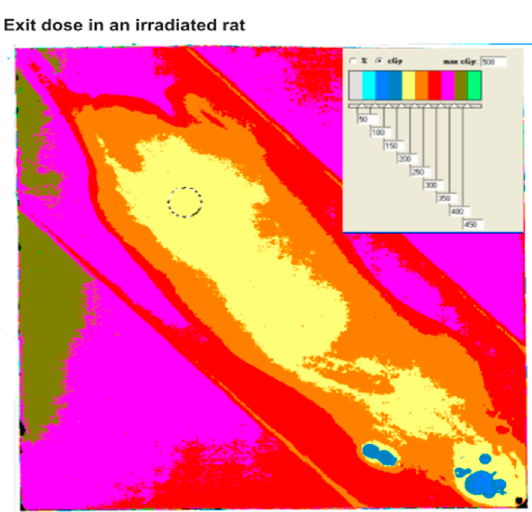
Figure 7 Exit dose measured with a radiochromic film under the irradiated animal. Figure 7. Exit dose measured with a radiochromic film under the irradiated animal. Entrance dose can be evaluated from the percentage depth dose curves and the animal